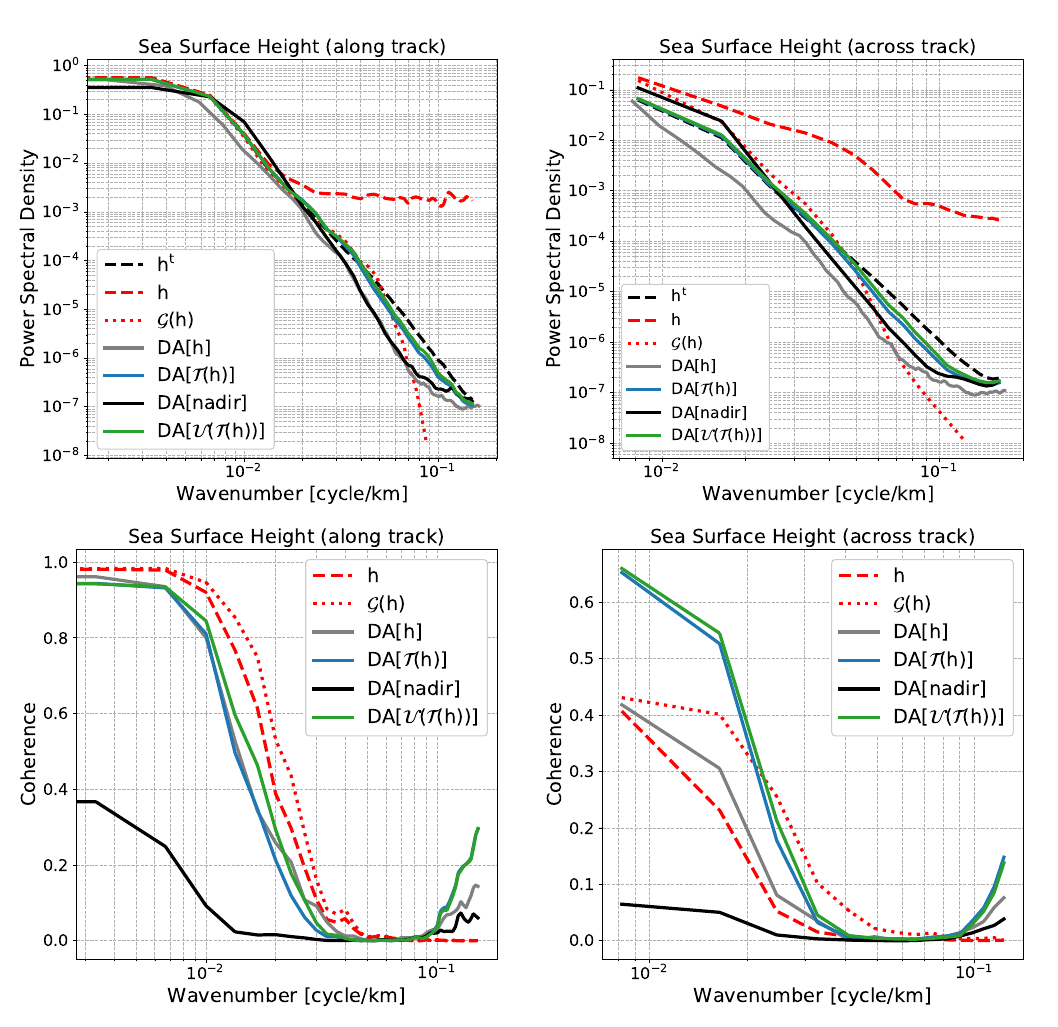
Figure 11. Same as Figure 8 but compares two additional results: DA[nadir] and DA[ U ( T ( h ))